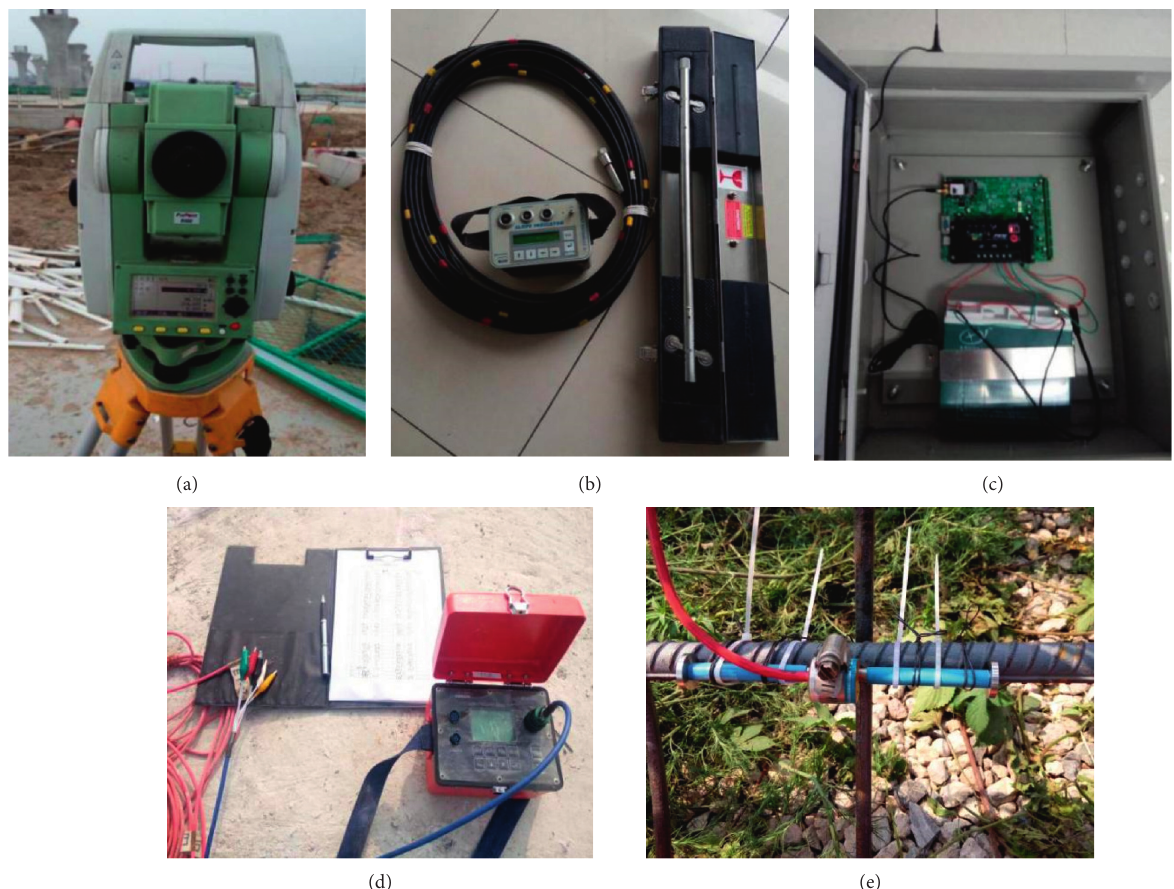
Figure 5: Field test monitoring instruments. (a) Electronic total station. (b) Clinometer. (c) Remote automatic displacement monitoring system. (d) Strain collector BGK408. (e) Strain gauge BGD-4200.